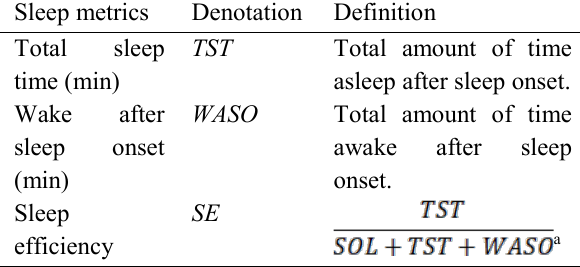
Table 1. Denotations and definitions of sleep